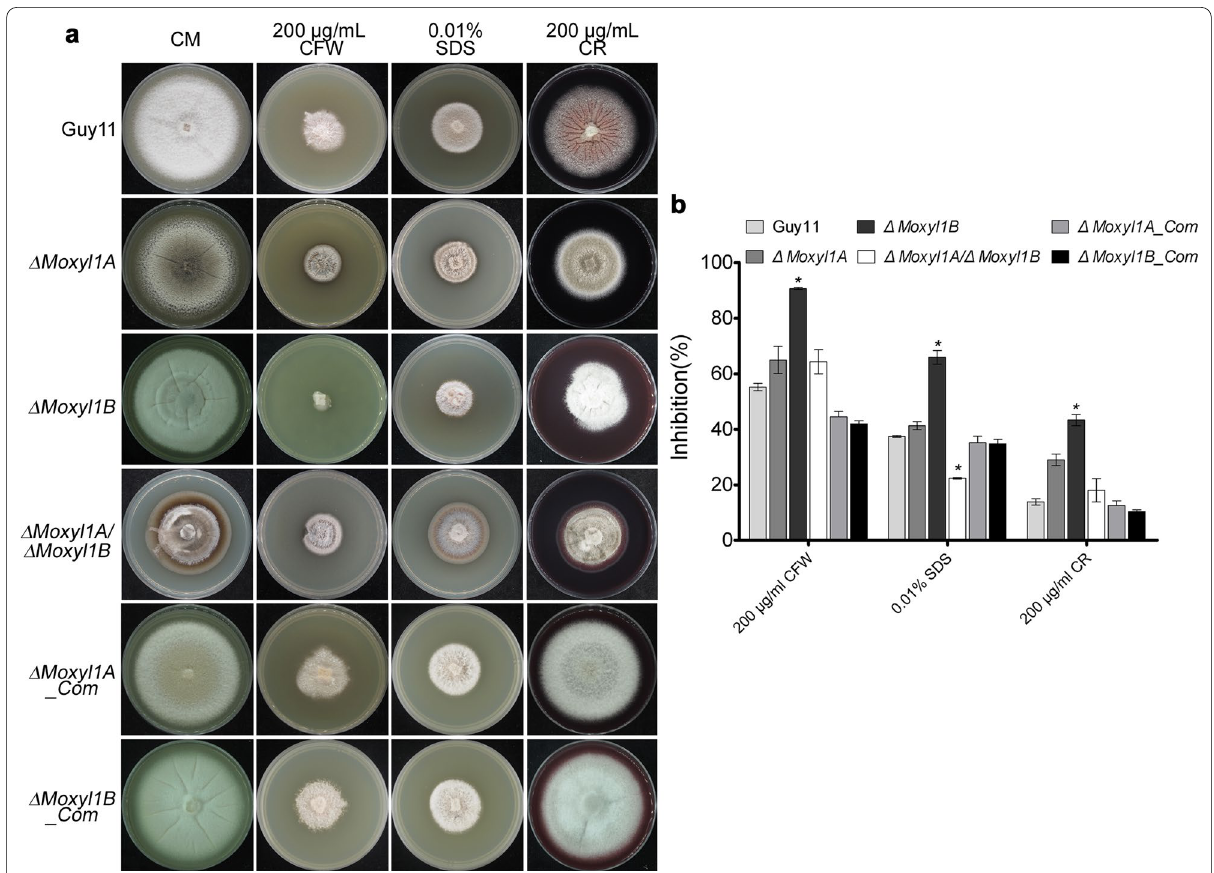
Fig. 3 MoXYL1A and MoXYL1B mutants show varying degrees of sensitivity to cell wall perturbing agents. a Physical inhibitory effect of selected cell wall stress-inducing agents on the vegetative growth of the individual strains. The strain were cultured on CM media supplemented with 200 μg/mL Calcofluor White (CFW), 0.01% SDS or 200 μg/mL Congo Red (CR) for 10-days. b Quantification and statistical evaluation of the response of MoXYL1 single and double deletion mutants and the wild-type strain to different cell wall stress inducing reagents. The inhibition data was generated from five independent biological experiments with five technical replicates each. One-way ANOVA (non-parametric) statistical analysis was carried out with GraphPad Prism8 and Microsoft Excel. Error bars represent standard deviation. Inhibition rate was calculated as a percentage (the diameter of control the diameter of treatment)/ (the diameter of control) 100. Single asterisk represents a significant = − × difference ( p <